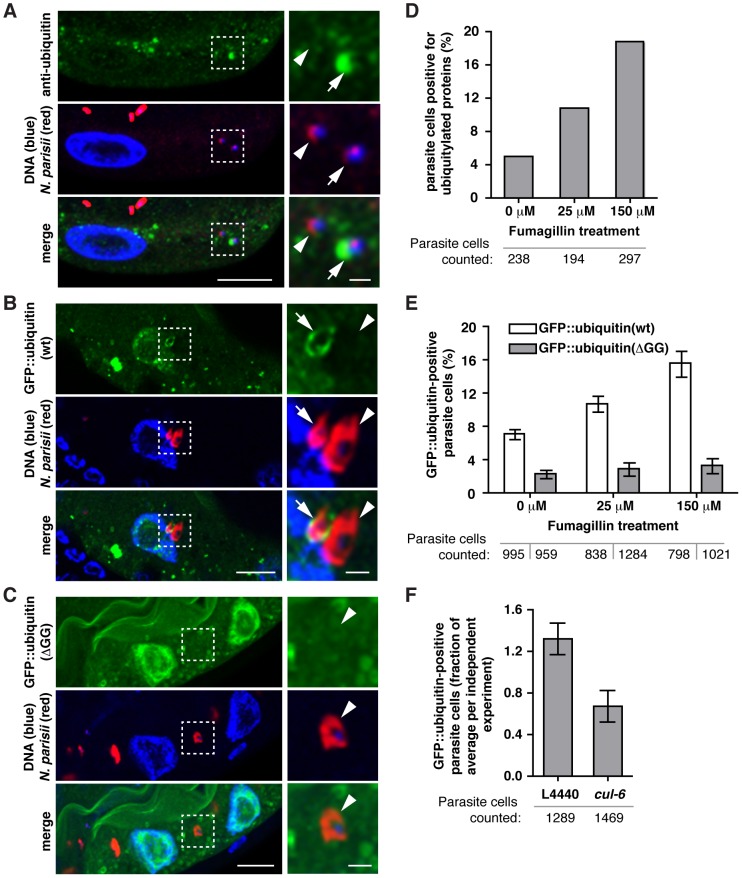

N. parisii cells are targeted by host ubiquitin early during infection.A–C) C. elegans intestines stained with a FISH probe against N. parisii rRNA (red), and DAPI for DNA (blue). A section of the image outlined by a dotted square is enlarged on the right and shows both an N. parisii parasite cell that colocalizes with ubiquitin (arrow), and one that does not (arrowhead). A) Animals were stained with an anti-conjugated-ubiquitin antibody, FK2 (green), and B, C) Transgenic C. elegans intestines expressing wild-type (B) or conjugation-defective mutant (C) GFP::ubiquitin (green). For A–C, scale bar  = 10 µm in main images and 2 µm in enlarged sections. D) Quantification of parasite cell colocalization at 12 hpi (see Materials and Methods for timepoint information) with FK2 antibody in the presence of increasing doses of fumagillin. Difference is significant: chi-squared test, p<6.3E-28, all comparisons. E) Quantification of parasite cell colocalization at 15 hpi with wild-type or mutant GFP::ubiquitin in the presence of increasing doses of fumagillin. Mean +/− SEM of two independent experiments is shown. F) Quantification of parasite cell colocalization at 15 hpi with wild-type GFP::ubiquitin following knockdown of cul-6 RNAi compared to L4440 vector control. Targeting of ubiquitin to parasite cells was less robust and more variable in animals feeding on HT115 RNAi bacteria compared to OP50-1 E. coli, ranging from 10.6% to 2.2% in control animals, and 2.1% to 1.8% in cul-6 RNAi treated animals and the data presented are normalized for the average level of targeting in each independent experiment. Mean +/− SEM of three independent experiments is shown. Number of individual parasite cells assessed for colocalization with ubiquitin is indicated.